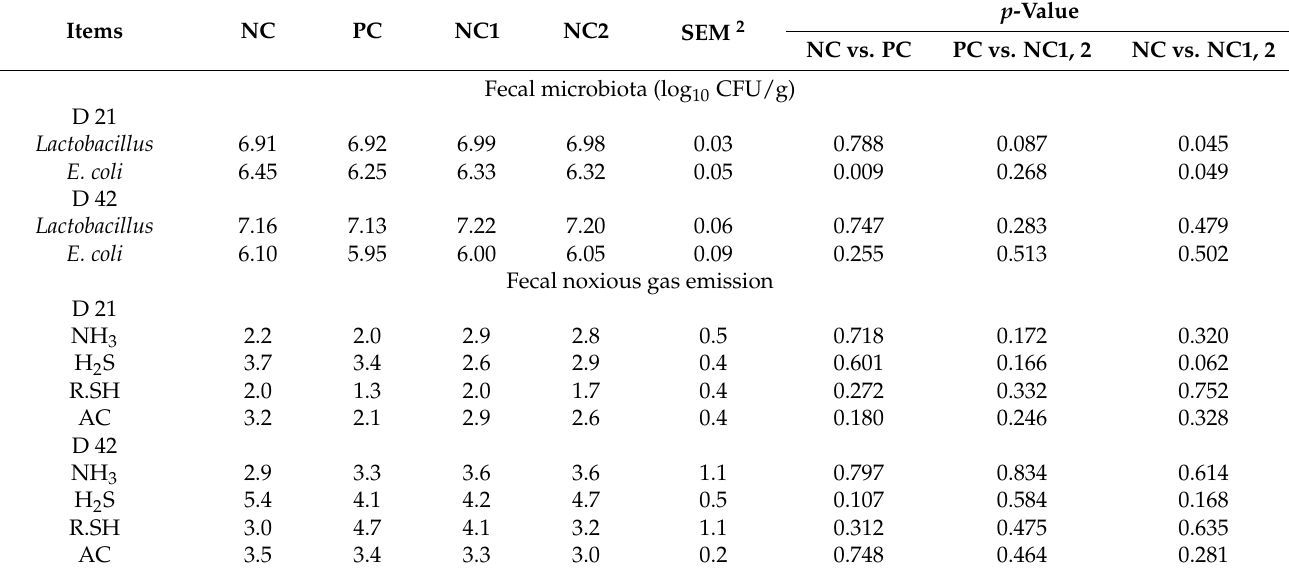
Table 5. Effect of dietary Lactobacillus plantarum BG0001 supplementation on fecal microbiota and fecal noxious gas emission in weaning pigs 1